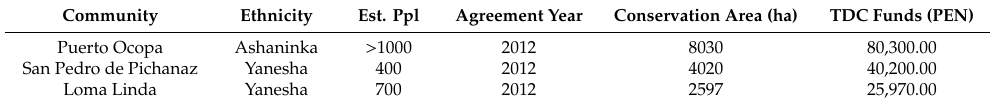
Table 1. General information on the indigenous communities.